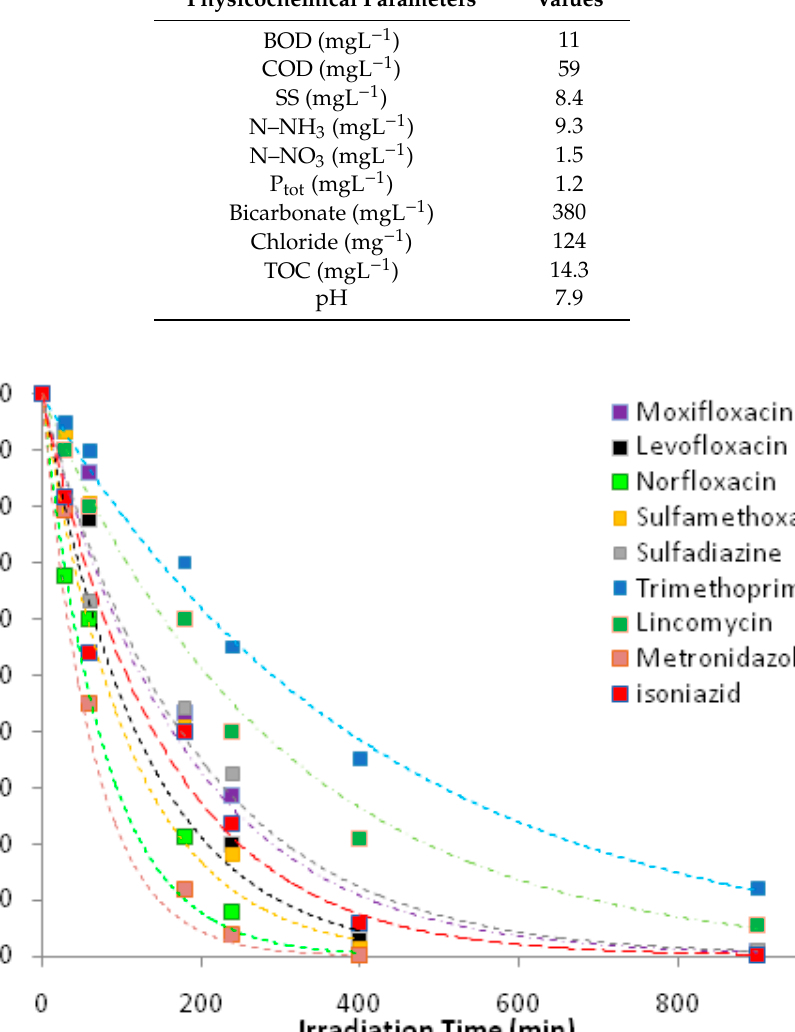
Table 4. Physisochemical characteristics of the wastewater effluent.